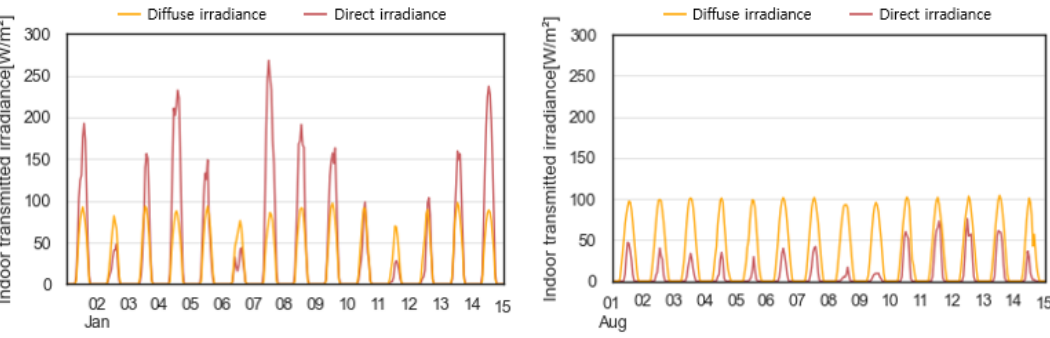
Figure 6. Simulation results: Indoor transmitted irradiance: winter ( left ), summer ( right ).